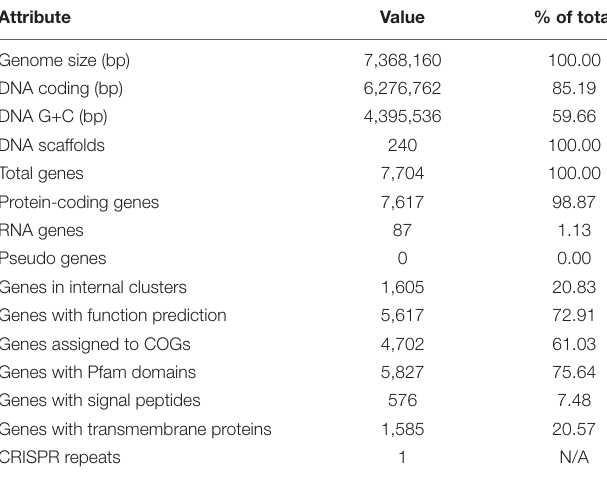
TABLE 1 | Genome statistics for Rhizobium favelukesii strain